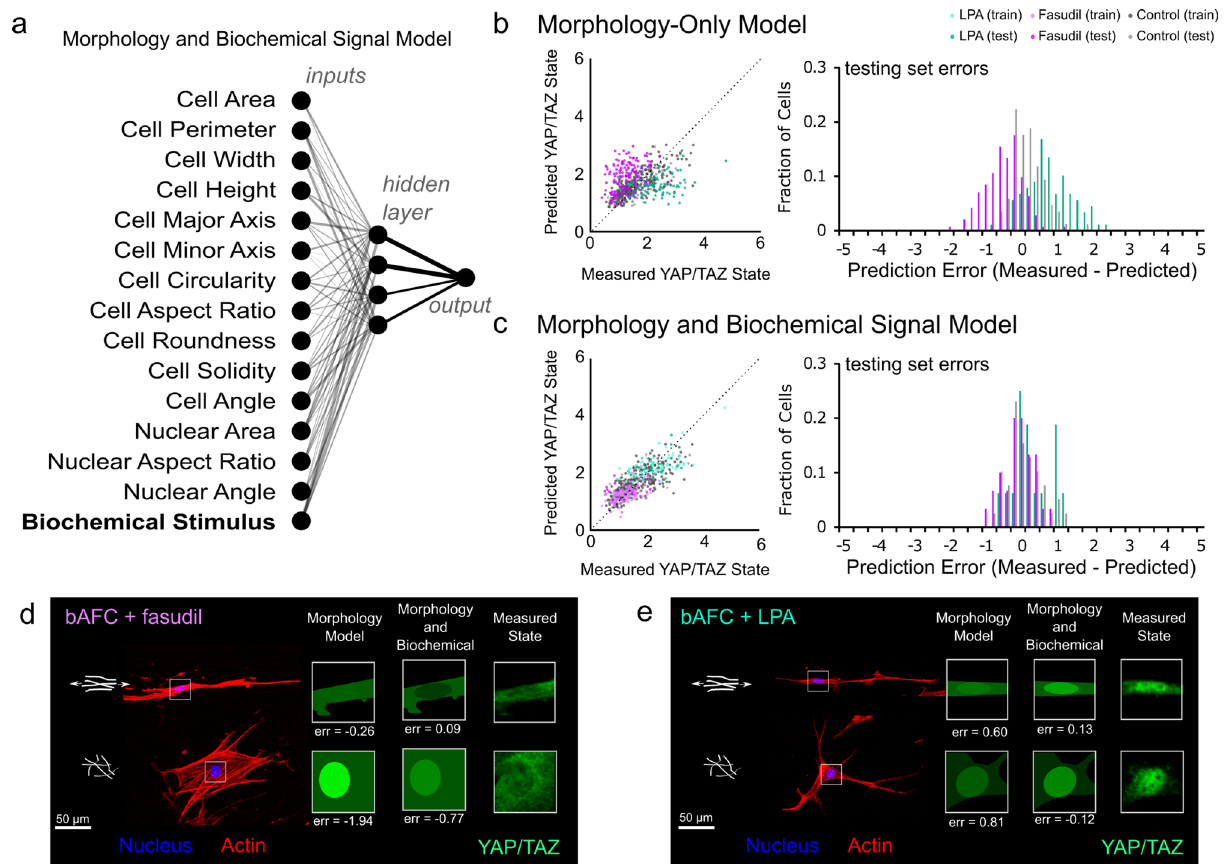
Figure 3. ( a ) To account for the role that biochemical signaling can play in YAP/TAZ localization, a neural network was constructed that incorporates cell and nuclear morphology in addition to information on biochemical signaling. Line thicknesses correspond to connection weights. ( b ) Using a morphology-only neural network provides either over (fasudil, ROCK inhibition) or under (LPA, rhoA activation) predictions of YAP/ TAZ state. ( c ) Incorporating biochemical signaling into the model increases model accuracy with no loss of predictability for control group cells. Example cells from the ( d ) Fasudil and ( e ) LPA groups along with visual depictions of the model predictions for both models (new model: n LPA-train = 73, n LPA-test = 16, n Fasudil-train = 112,